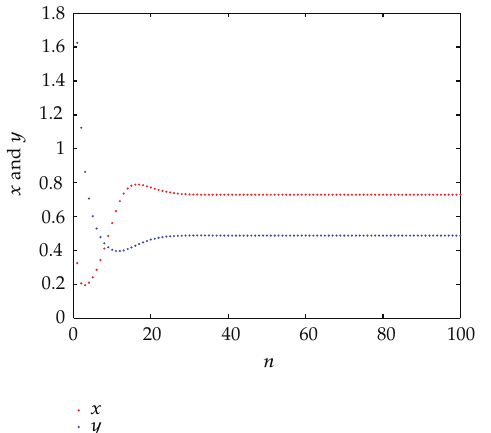
Figure 2: System (cid:6) 3.2 (cid:7) in the optimal balance point P α (cid:6) 0 . 72883022165025259637411853051416, 0 . 72883022165025259637411853051416 (cid:7) . There is an optimal degree of capture e ff ort (cid:6) 0 . 99197566015688 , 0 . 03832235272285 (cid:7)